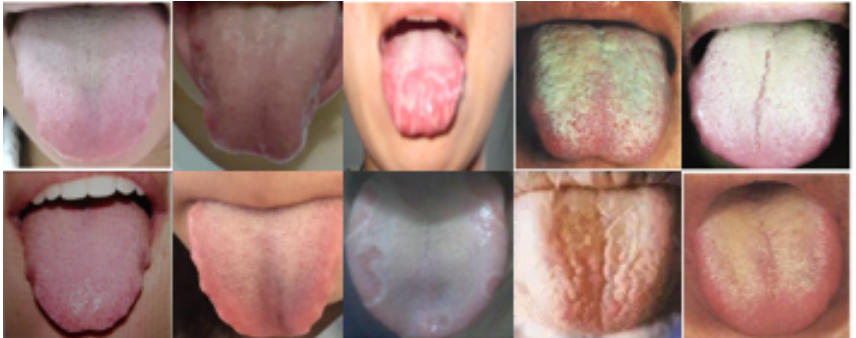
Figure 10. Tongue images in the open environment.